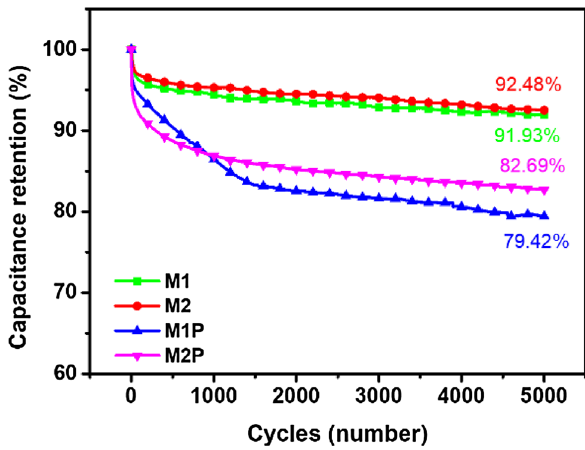
Figure 6. The cyclic capacity retention during 5000 cycles at 1